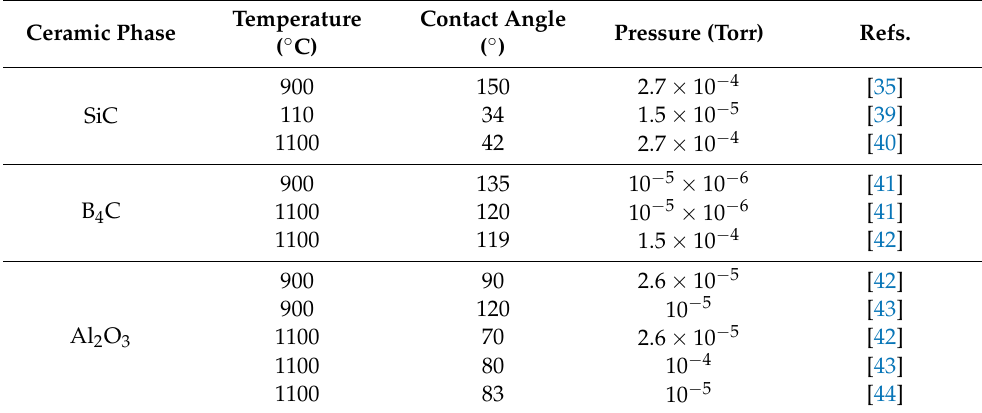
Table 1. Contact angle of ceramic particles in aluminum of different